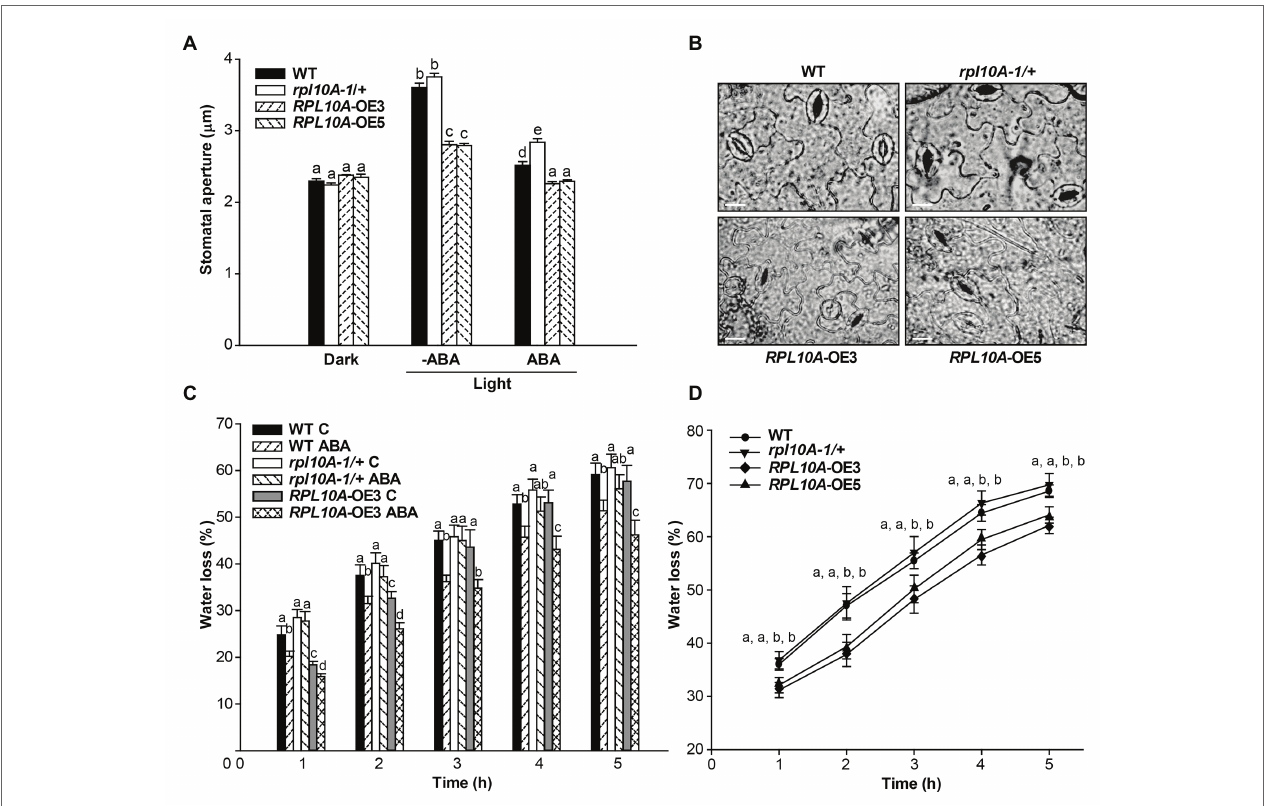
FIGURE 6 | Effect of ABA on stomatal aperture and water loss. (A) Stomatal aperture was measured on epidermal peels of leaves #5 from WT, rpl10A-1/+ mutants, and RPL10A -overexpressing lines ( RPL10A -OE3 and RPL10A -OE5) plants after 2 h in the dark and subsequent incubation without ( − ABA) or with 20 μ M ABA (+ABA) under white light for 2 additional hour. Results are the mean of three independent experiments ± SE For each experiment, at least three leaves from three different plants were used and 60 stomata were analyzed. For each genotype and condition (dark and light with or without 20 μ M ABA), different letters over the bars indicate significant differences applying ANOVA test at p < 0.05. (B) Representative images of abaxial epidermis peeled from leaves #5 of 3-week-old WT, rpl10A-1/+ mutants, and RPL10A -overexpressing lines ( RPL10A -OE3 and RPL10A -OE5) plants incubated with 20 μ M ABA under white light for 2 h. Bar = 10 μ m. (C) Water loss of air-dried leaves #5 from 3-week-old WT, rpl10A/+ mutant and RPL10A -OE3 plants after petiole-feeding with 20 μ M ABA or water (Control, C ) for 1 h under white light. Fresh weight was measured every hour and data were normalized to the initial fresh weight. Results represent the average of three independent experiments ± SE, n = 10 for each biological replicate. At each time, for each genotype and condition (with or without 20 μ M ABA), different letters over the bars indicate statistical differences applying ANOVA test ( p < 0.05). (D) Water loss of air-dried rosettes from 3-week-old WT, rpl10A-1/+ mutant, and RPL10A - overexpressing plants ( RPL10A -OE3 and RPL10A -OE5) maintained under control conditions. Fresh weight was measured every hour and data were normalized to the initial fresh weight. Results represent the average of three independent experiments ± SE, n = 10 for each biological replicate. Different letters indicate statistical differences between genotypes at each time applying ANOVA test at p <